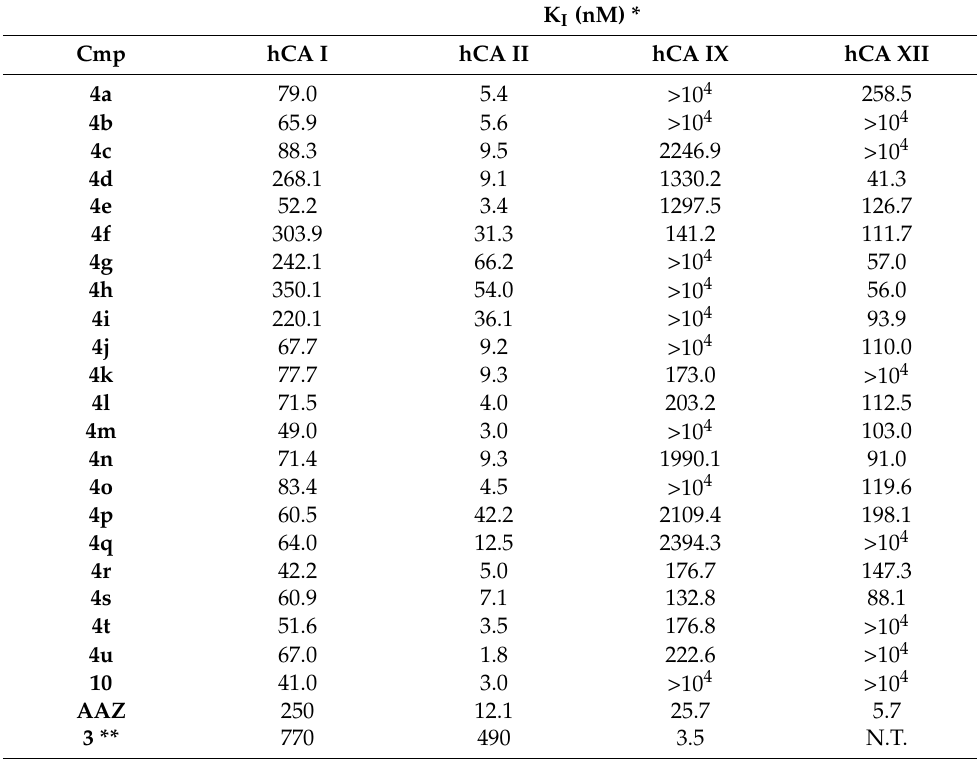
Table 1. Inhibition of hCAs I, II, IX and XII with indoline-5-sulfonamides 4a – 4u , 10 and AAZ and 3 as